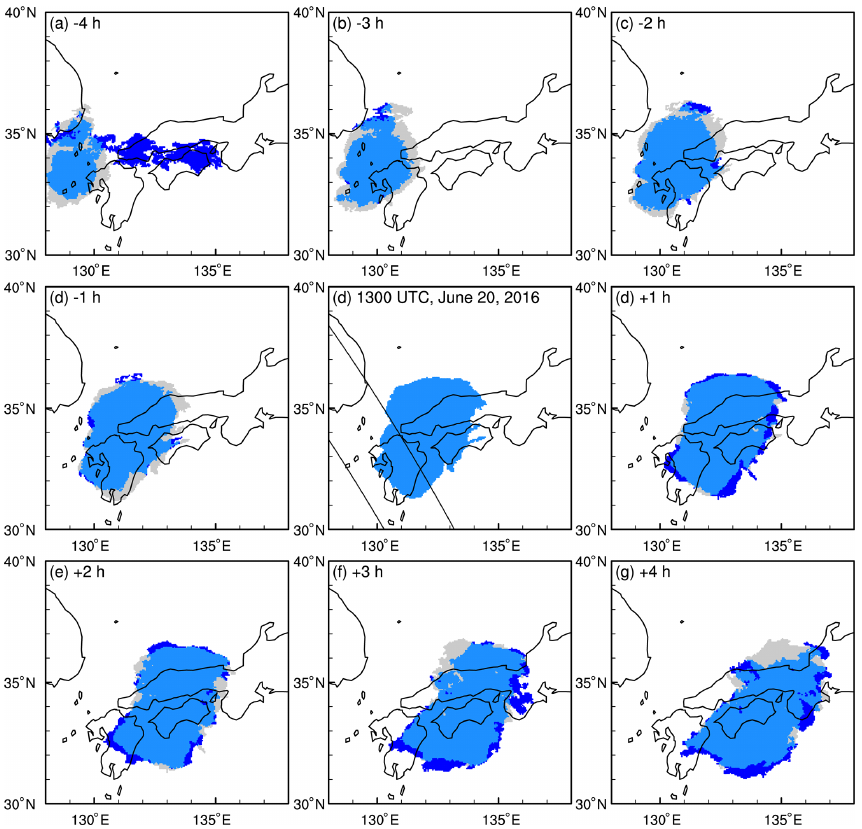
Figure 8. Demonstration of the tracking process for the precipitation event occurring at about 13:00UTC on 20 June 2016. The light blue and deep blue areas indicate the actual MCS. The gray and light blue areas indicate the calculated MCS from the last